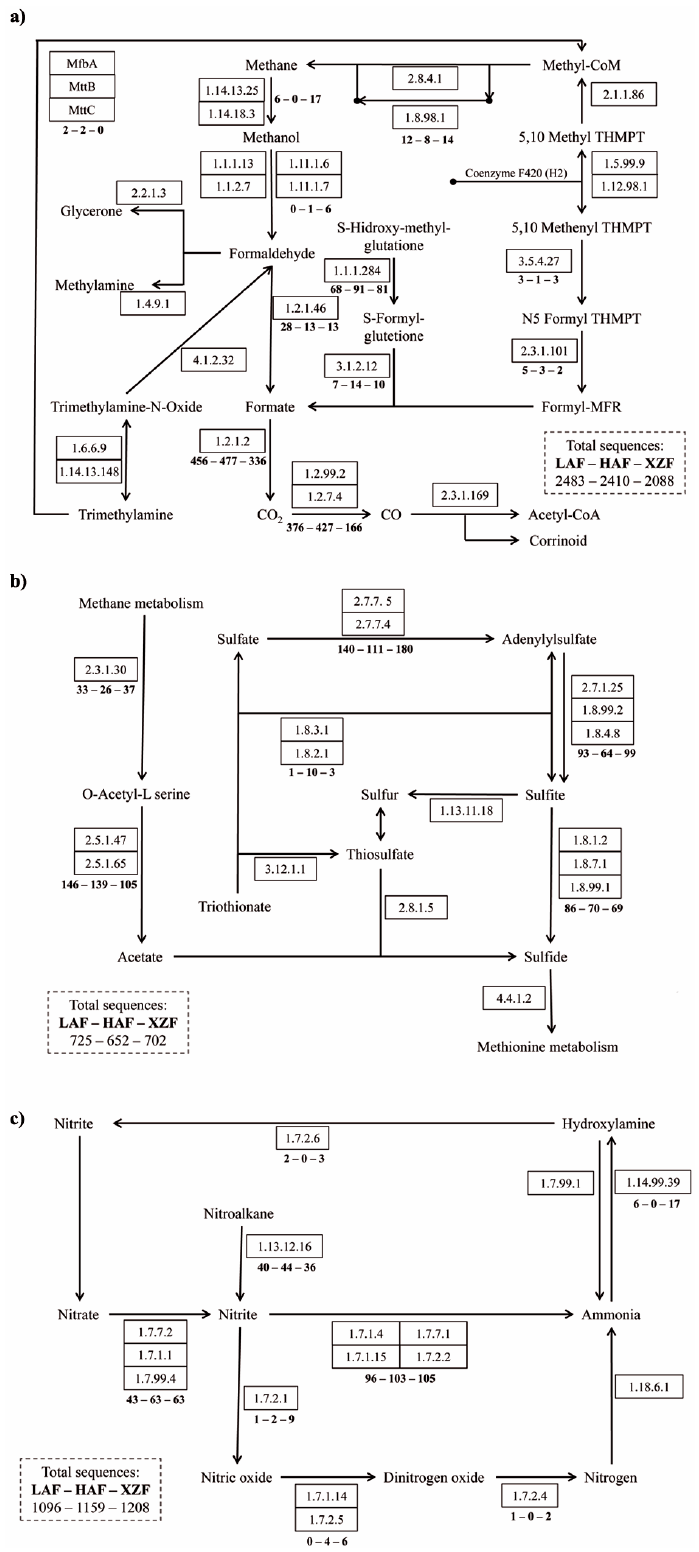
Figure 4. Partial pathways of methane metabolism ( a ), sulfur metabolism ( b ) and nitrogen metabolism ( c ). Total sequences per sample are indicated by discontinuous line boxes. Sequences obtained for each protein or protein group are indicated under the continuous line boxes, separated between dashes for each sample (always in the order LAF–HAF–XZF).